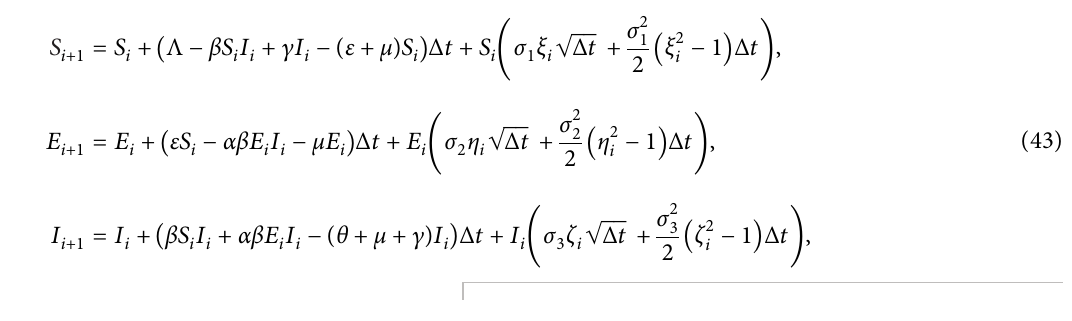
Figure 2: S ( t ) ,E ( t ) ,I ( t ) is the solution to the deterministic model (1), and S 1 1 1 Here, c, and d is the case of I ( t ) in t ∈ [ 0 , 150 ] and t ∈ [ 0 , 1000 ] ,